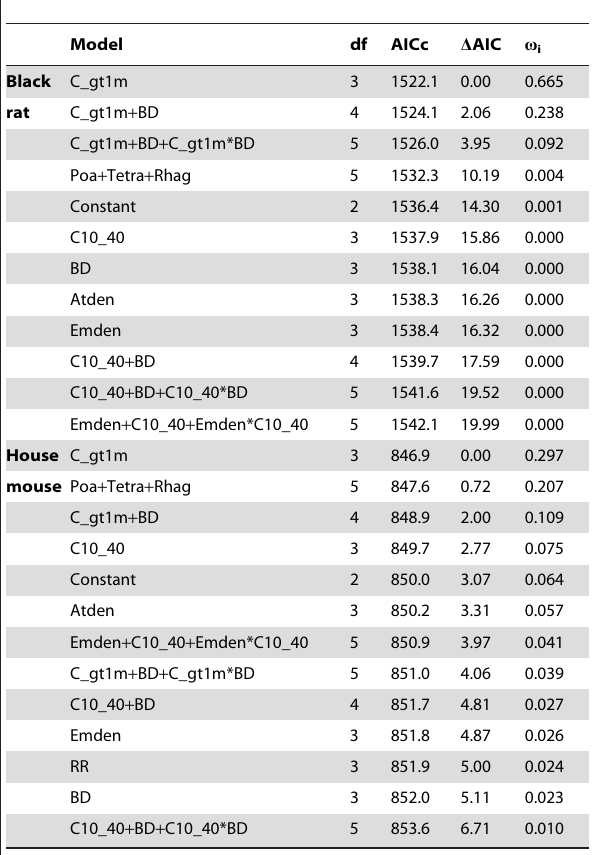
Table 3. AICc based model selection for different species identified through camera trapping on the Summerland